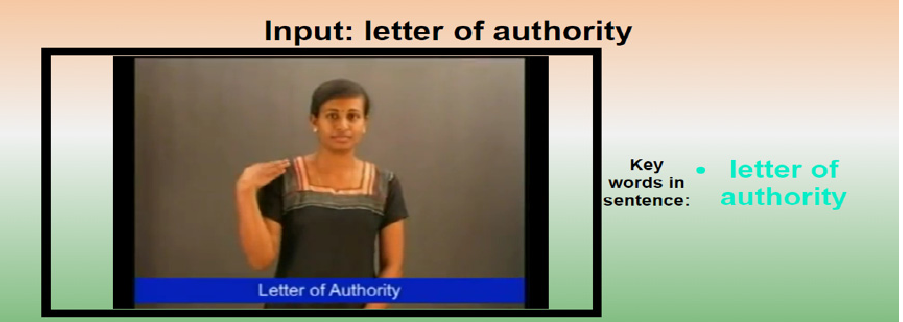
Figure 15. Case 6. Available video for ‘letter of authority’.